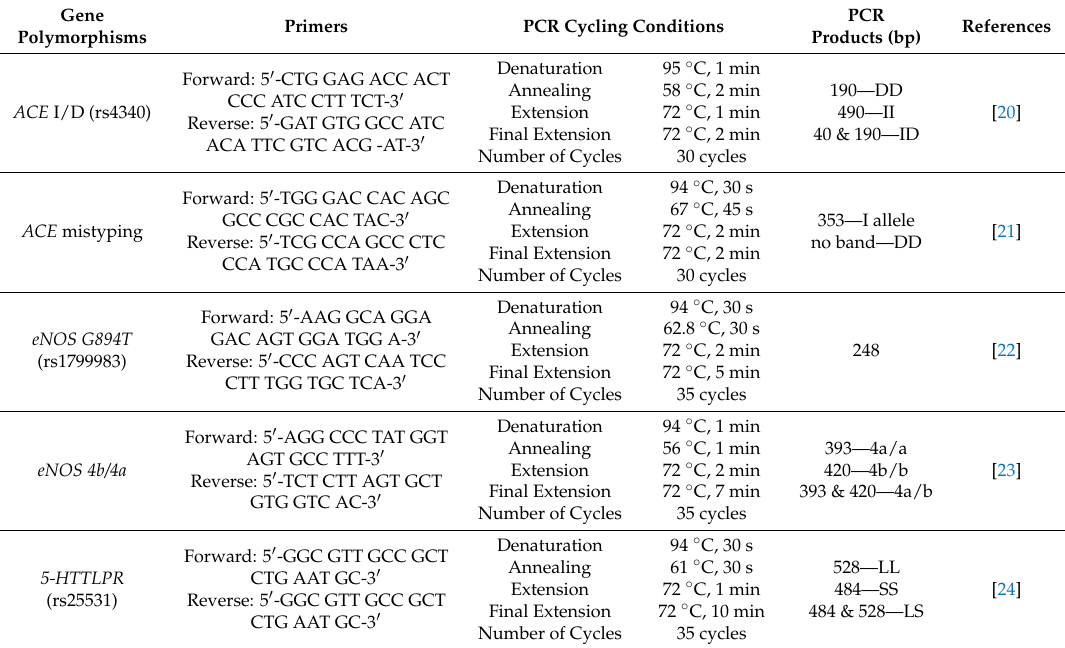
Table 1. Primers and PCR product for each gene